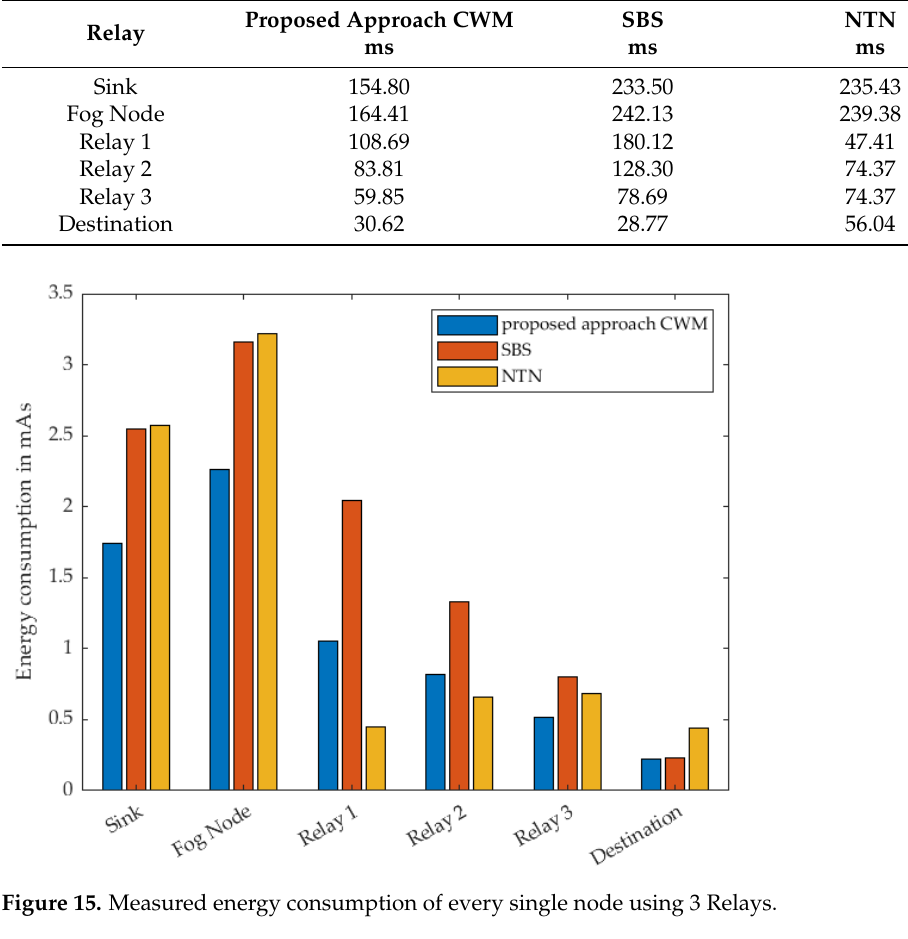
Figure 15. Measured energy consumption of every single node using 3 Relays.